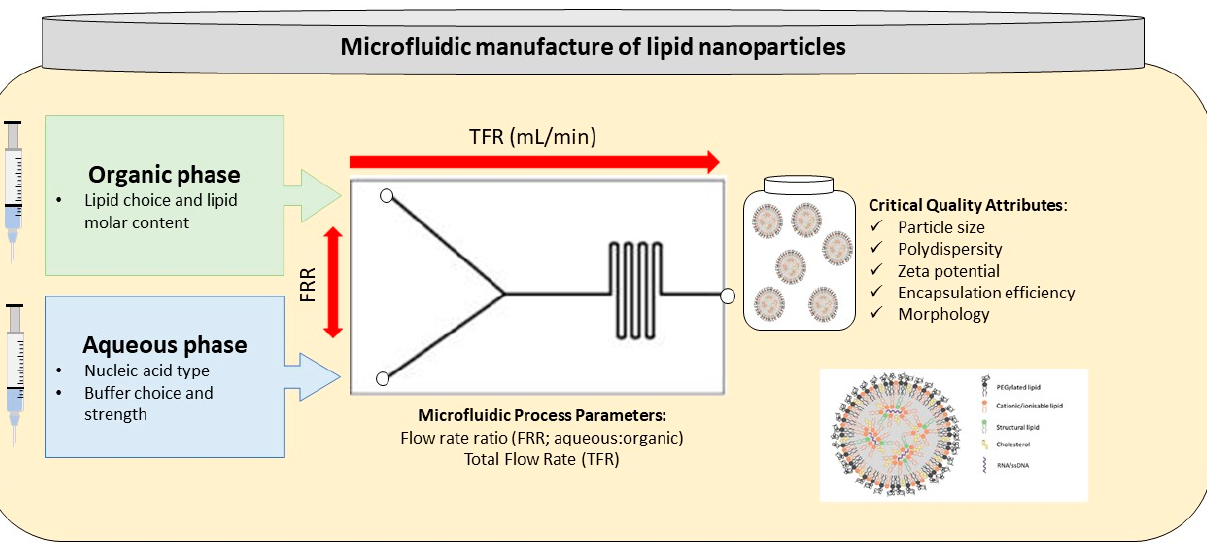
Figure 3. Schematic representation of LNP-based delivery systems manufacturing through microfluidic methods. Adapted from [33], published by MDPI, 2020.